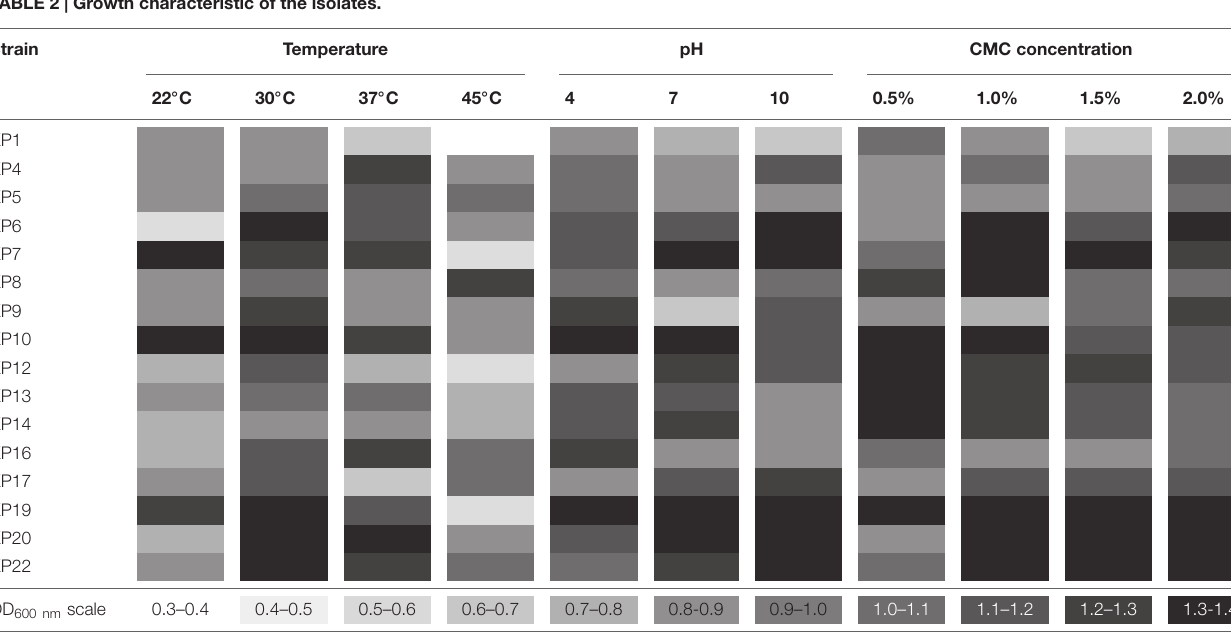
TABLE 2 | Growth characteristic of the